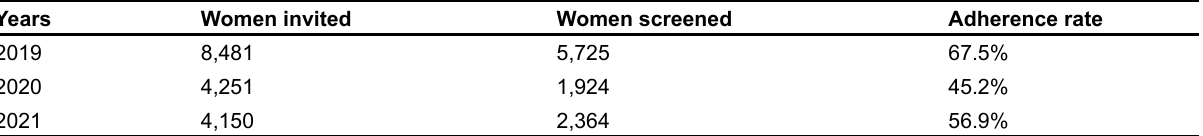
Table 6. Adherence rate to screening from 2019 to 2021